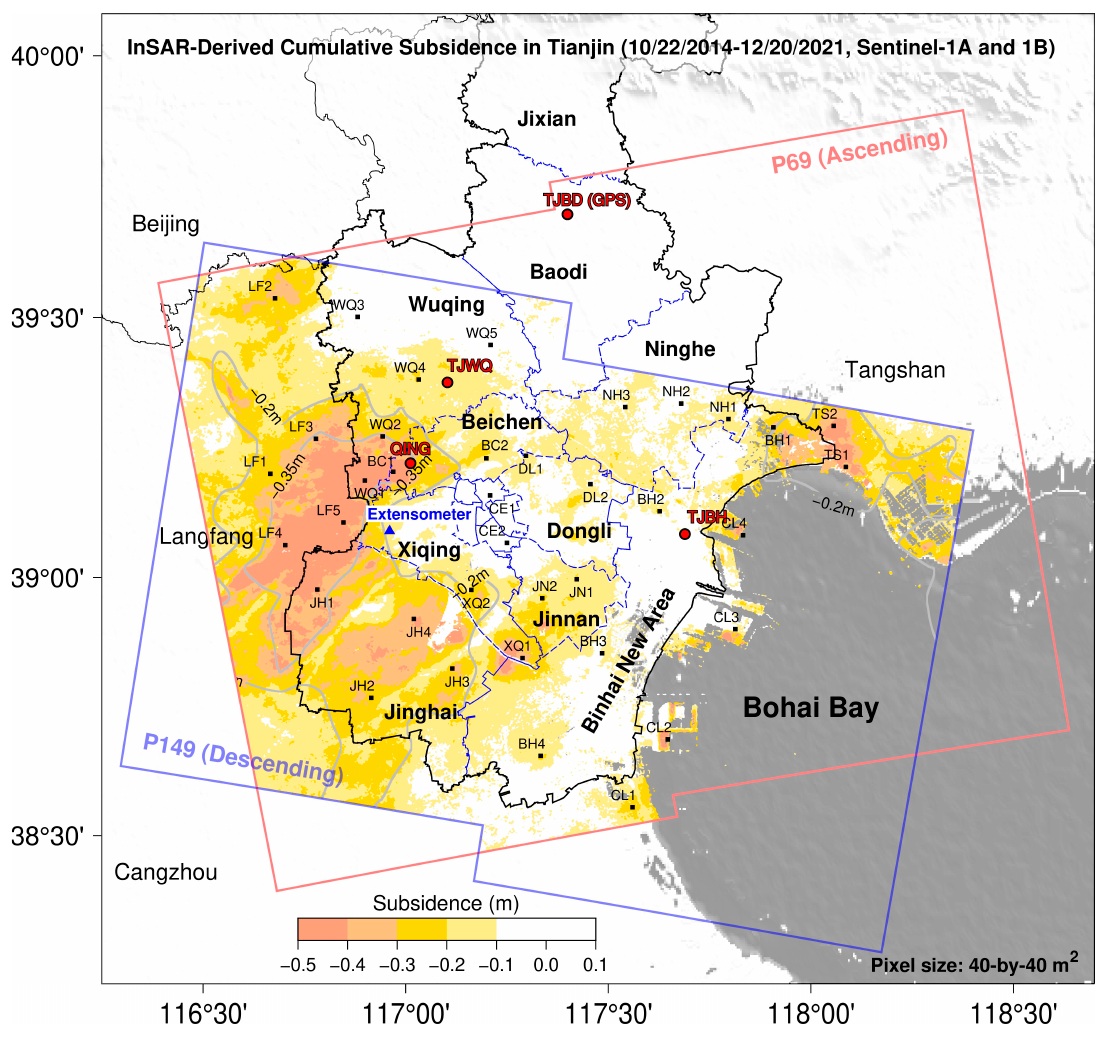
Figure 7. The cumulative subsidence derived from Sentinel-1A/B SAR data spanning approximately seven years (22 October 2014–20 December 2021). The land area covered by both paths (P69 and P149) is approximately 15,500 km 2 , among which 10,100 km 2 is within Tianjin, about 85% of the total land area (~11,900 km 2 ) of